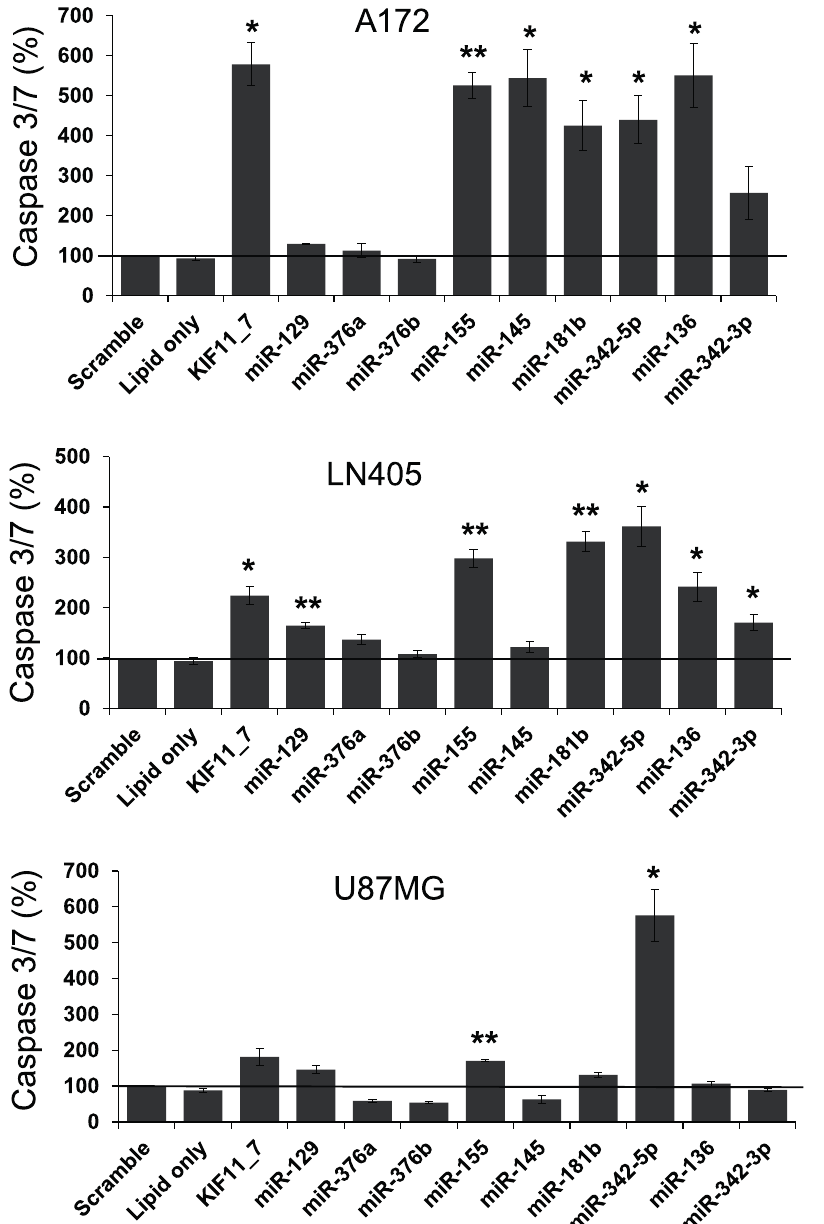
Figure 3. Validation of the precursor hit miRNAs that reduced proliferation with the Caspase 3/7 Glo assay 72 h after transfection (n=3 biological, 4 technical repeats). Values are mean + / 2 s.e.m.; statistically significant changes are shown with asterisks (*p , 0.05, **p , 0.01, ***p , 0.001).